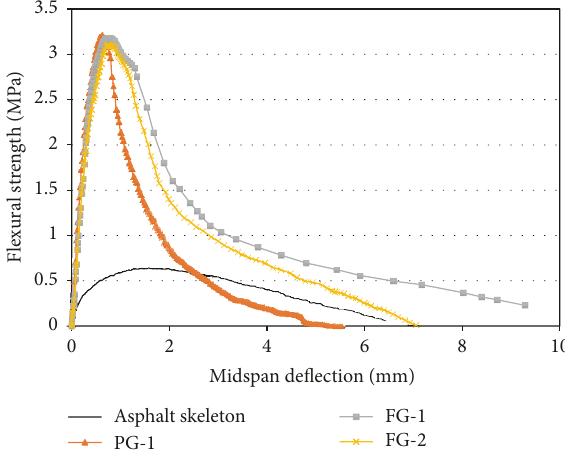
Figure 8: Results of flexural test of asphalt skeleton and semirigid asphalt specimens.